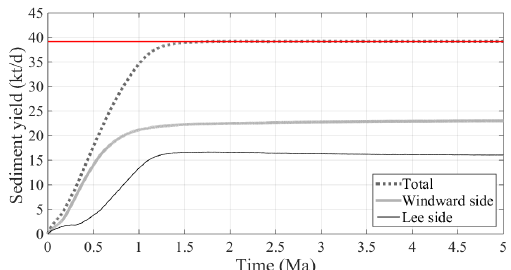
Figure 5. Time variation of sediment yield from co-evolution sim- ulation. Simulation is implemented with V = 16ms − 1 and t d = 1200s. Red horizontal line corresponds to the mass balance with the tectonic uplift